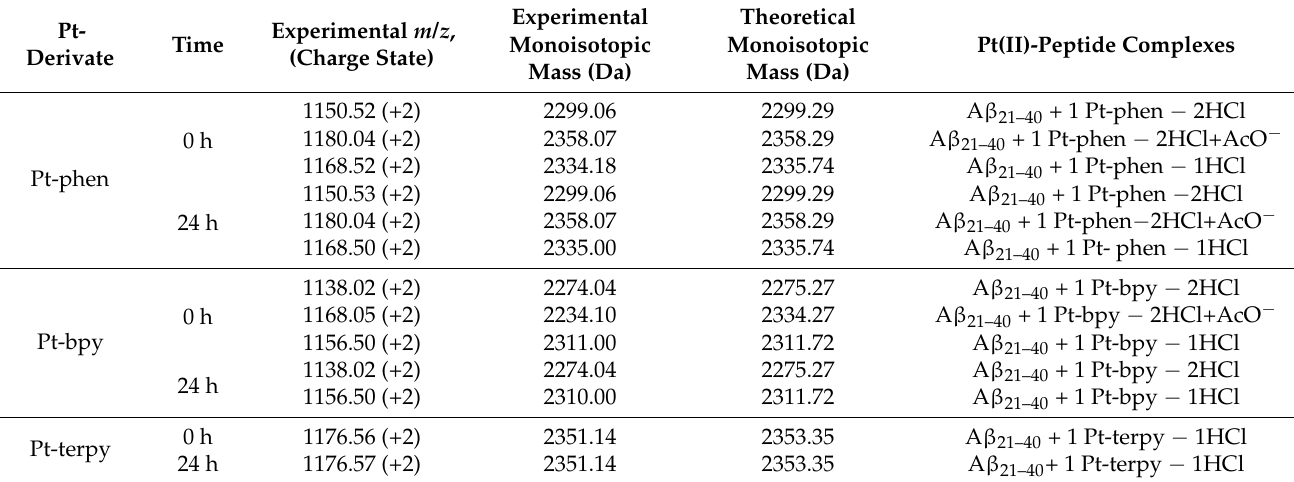
Figure 3. ESI-MS spectra of A β 21–40 peptide at 24 h of incubation with Pt-derivates. ( A ) Isolated A β 21–40 . ( B ) A β 21–40 + Pt-phen. ( C ) A β 21–40 + Pt-bpy. ( D ) A β 21–40 + Pt-terpy. The presence of the Pt moieties in the ions is indicated with 1, 2 and 3, respectively. Fragmentation ions are also indicated. Table 2. Summary of main ion species occurring in the ESI-MS spectra of A β 21–40 with the three Pt-derivates, at 0 and 24 h of incubation. Each detected adduct is reported with the corresponding experimental m/z values, the charge state, the calculated and theoretical monoisotopic molecular weight.